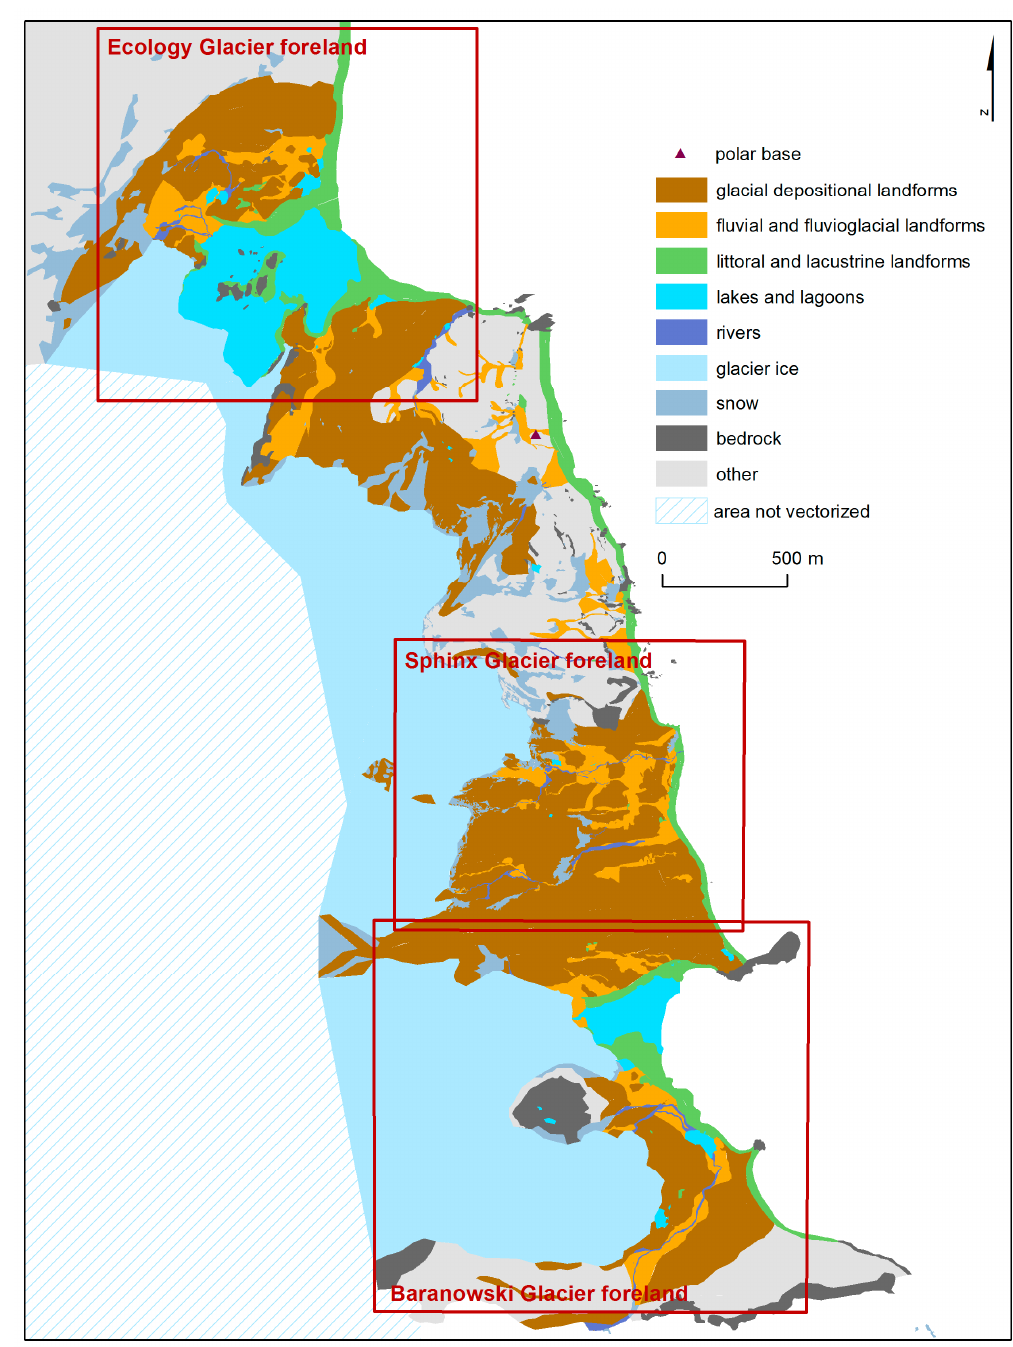
Figure 4. West coast of Admiralty Bay on King George Island and geomorphological setting of Ecology Glacier, Sphinx Glacier and Baranowski Glacier forelands; note a small seasonal US polar base between Ecology Glacier and Sphinx Glacier; map based on images obtained by the unmanned aerial vehicle [43].